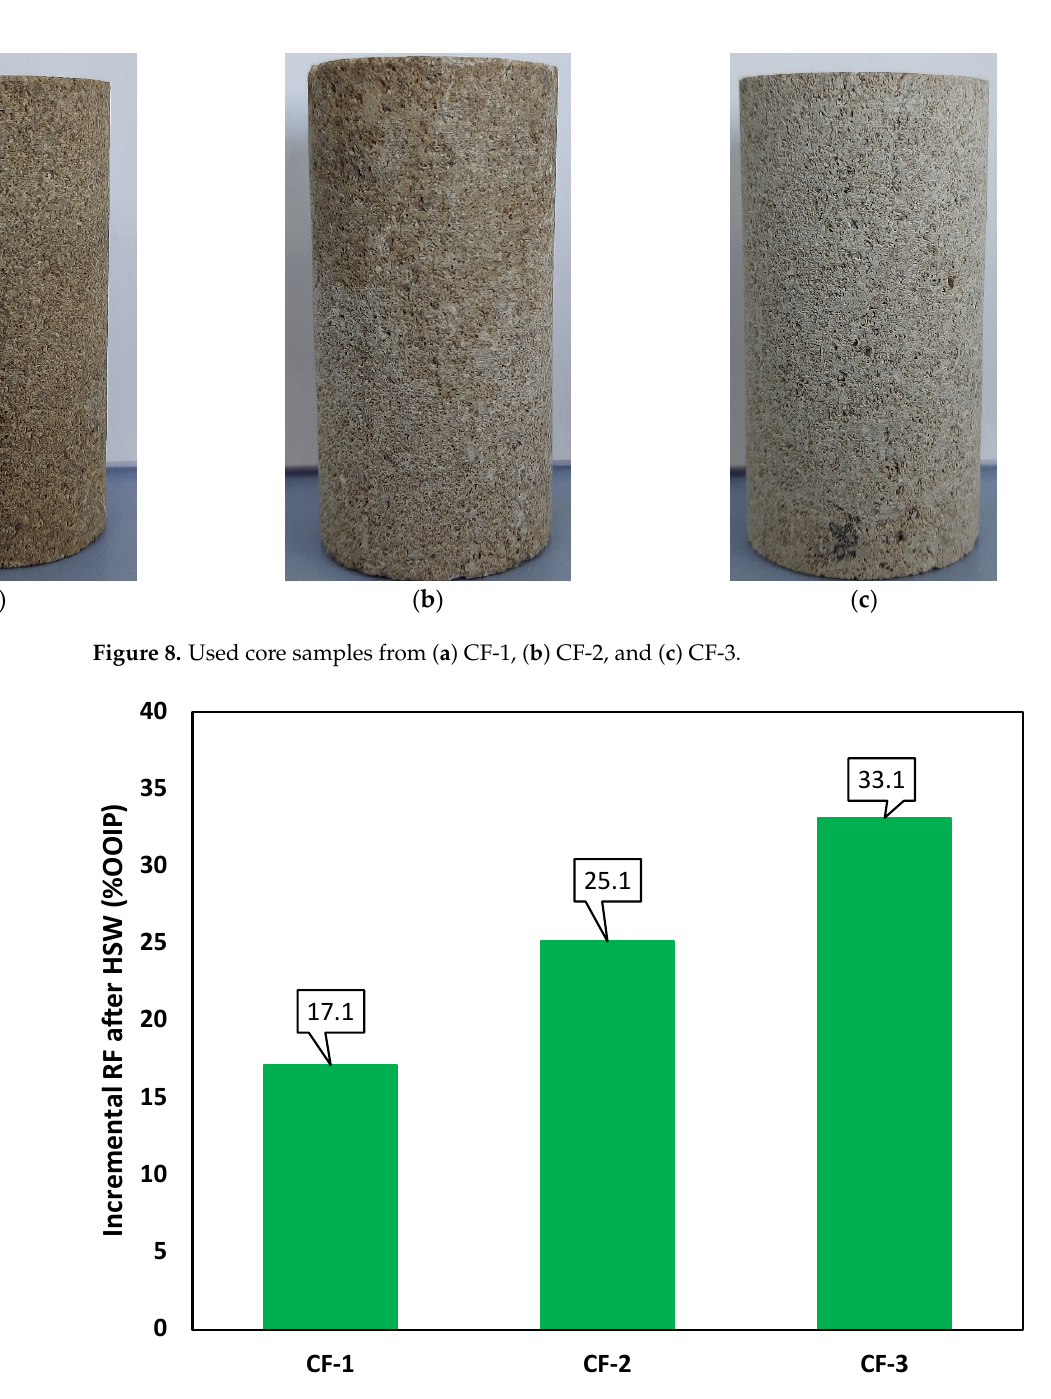
Figure 9. Comparison of incremental recovery factor for constant salinity (CF-1), sharper negative salinity gradient (CF-2), and gradual negative salinity gradient (CF-3) designs. A summary of the coreflood results is presented in Table 6. Both negative salinity gradient designs have exhibited higher incremental oil recoveries compared to constant optimum salinity design in terms of OOIC. However, the gradual negative salinity gradient profile shows the best performance in terms of the remaining oil in the core (ROIC), compared to the EWSF case and the sharper negative salinity gradient